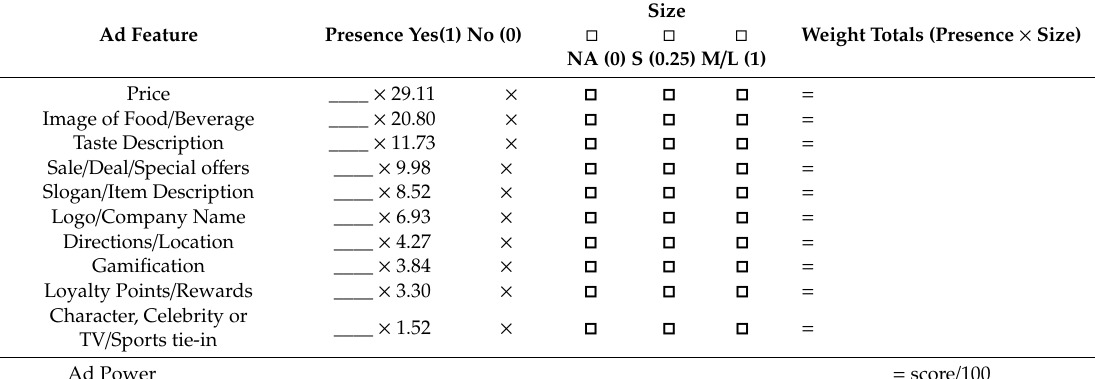
Table 3. Teen-informed coding tool for quantifying the power of food advertisements.